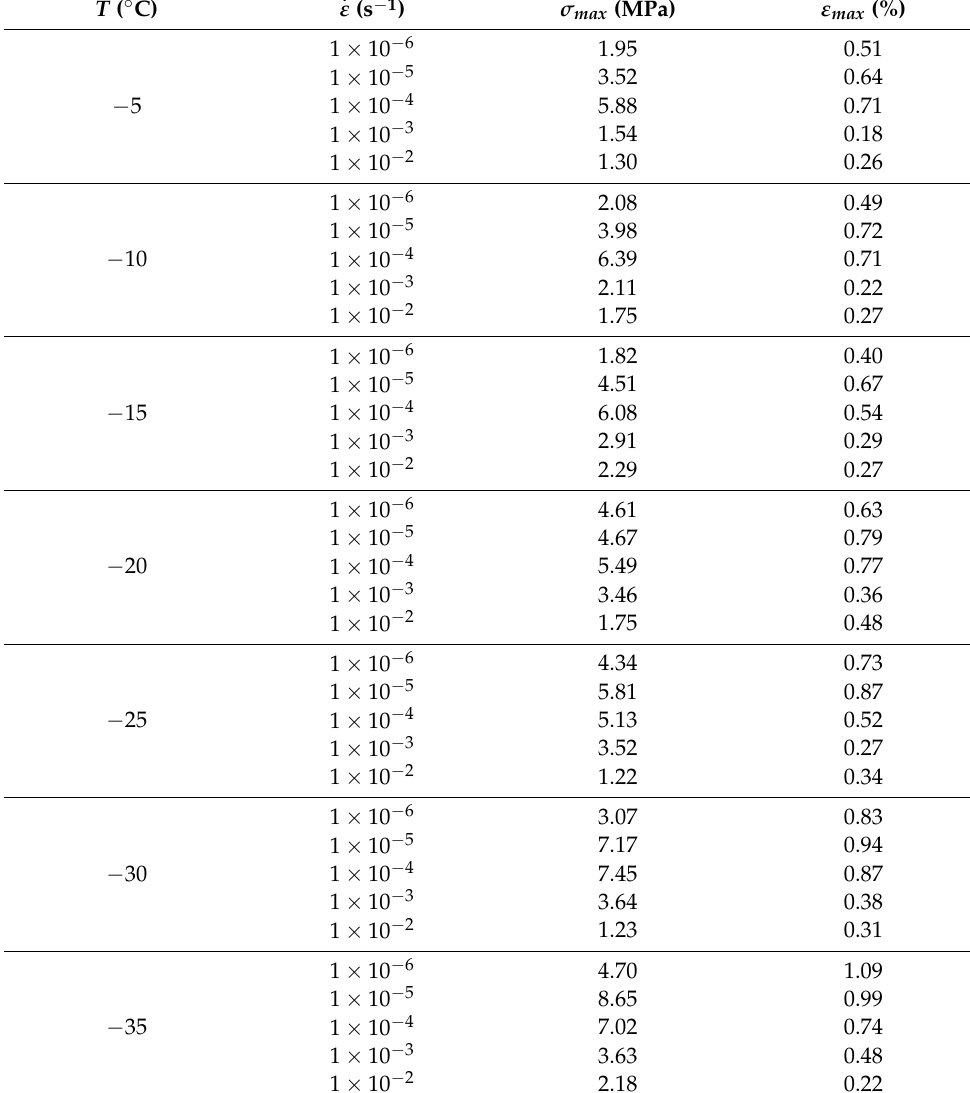
Table 1. Typical Experimental conditions and corrected